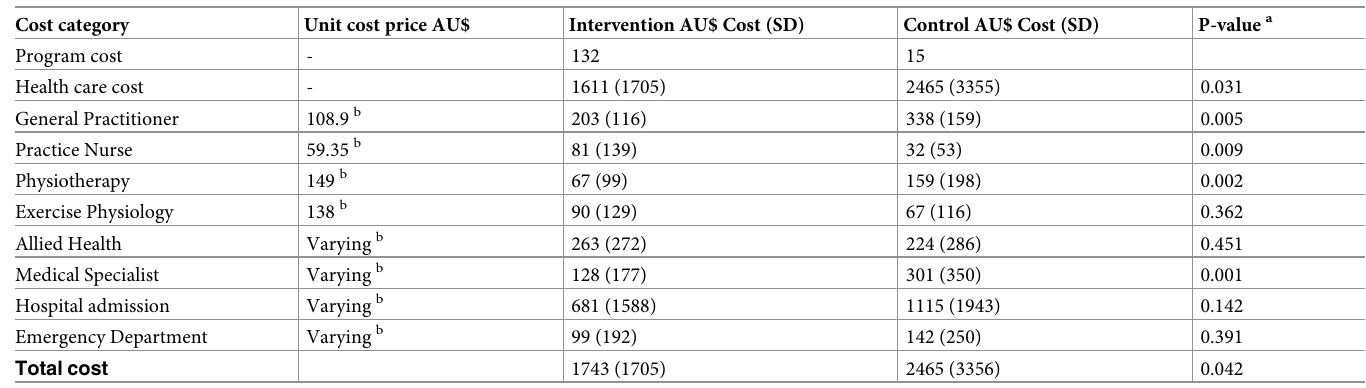
Table 2. Total program and healthcare resource costs.